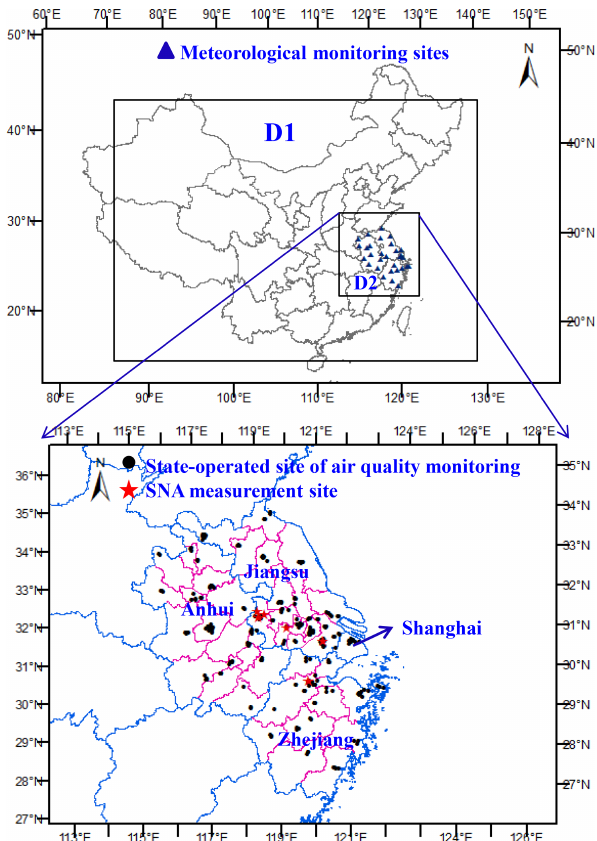
Figure 1. The modeling domain and locations of meteorological and air quality monitoring sites. The map data provided by the Resource and Environment Data Cloud Platform are freely avail- able for academic use (http://www.resdc.cn/data.aspx?DATAID= 201, last access: 20 January 2020). © Institute of Geographic Sci- ences & Natural Resources Research, Chinese Academy of Sci-